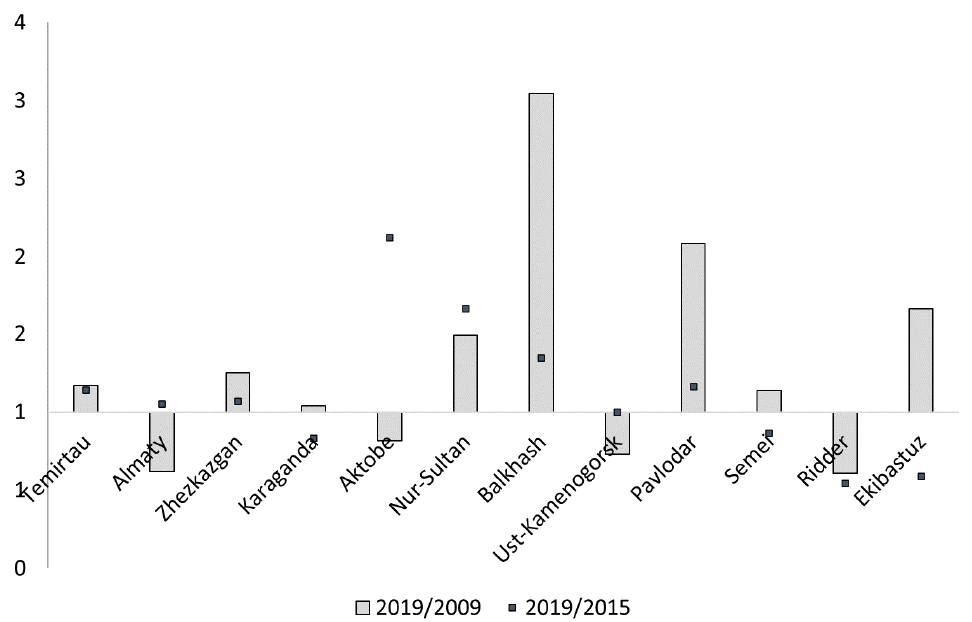
Figure 2. Changes in the air pollution index over 2015–2019 and 2009–2019 in the cities of Kazakhstan Source: [33].